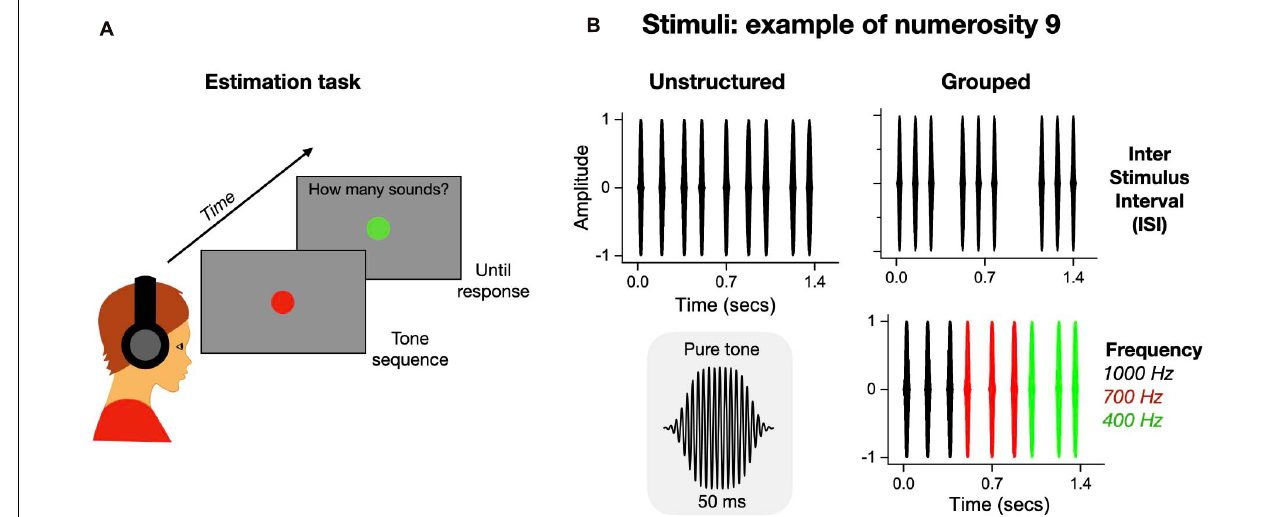
FIGURE 1 | Illustration of the procedure and stimuli. (A) Illustration of the numerosity estimation task. Participants kept gaze on a red central fixation point while a sequence of tones was played for 1.4 s. After the auditory stimulus had finished, the fixation point color changed from red to green, signaling to verbally report the perceived numerosity. (B) Example of auditory stimuli for numerosity nine in the three experimental conditions: unstructured, grouped by ISI and grouped by frequency. The gray insert shows the waveform of a single pure tone.